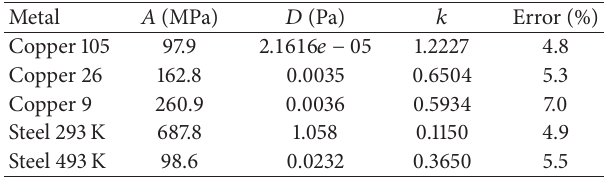
Table 6: Material constants and errors obtained by Cowper- Symonds